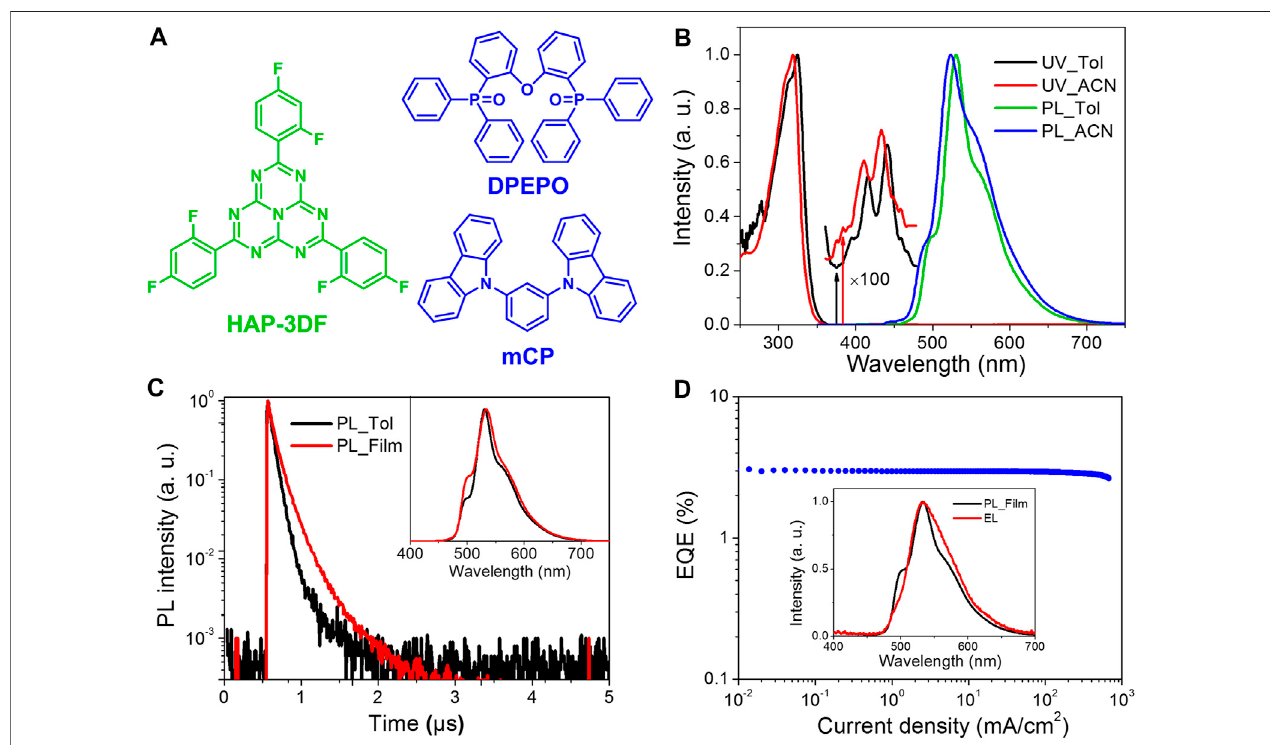
FIGURE 1 | (A) Chemical structures of HAP-3DF, DPEPO and mCP. (B) UV and PL spectra of HAP-3DF in toluene (Tol) and acetonitrile (ACN). (C) Transient PL decayandPLspectra(Inset)ofHAP-3DFintoluene(Tol)andDPEPO fi lm(8 wt%). (D) EQEcharacteristicsoftheOLEDincorporating8 wt%HAP-3DF:DPEPO.Inset:PL spectrum in 8 wt% HAP-3DF:DPEPO and EL spectrum recorded at a current density of 10 mA cm − 2